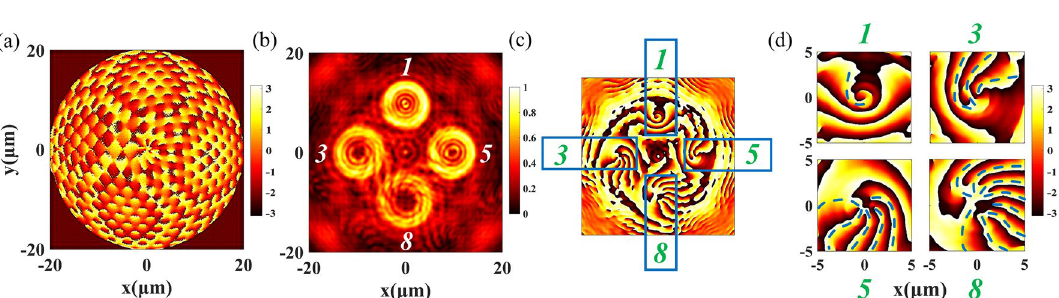
Figure 5. The non-coaxial array of Q-PV. ( a ) The design phase distribution of the Q-PV non-coaxial array; ( b ) The light field intensity distribution in the focal plane; ( c ) The phase distribution in the focal plane, the blue rectangle boxes out the phase of Q-PV at that position and TC; ( d ) The partially enlarged phase distributions in the focal plane, dotted lines indicate the position and number of phase